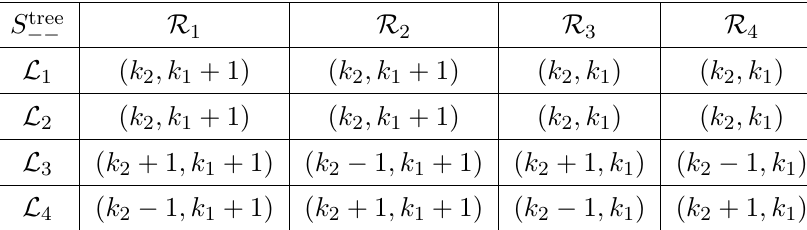
Table 7 . ( k L ; k R ) in all regions for the con(cid:12)guration S (cid:0)(cid:0)